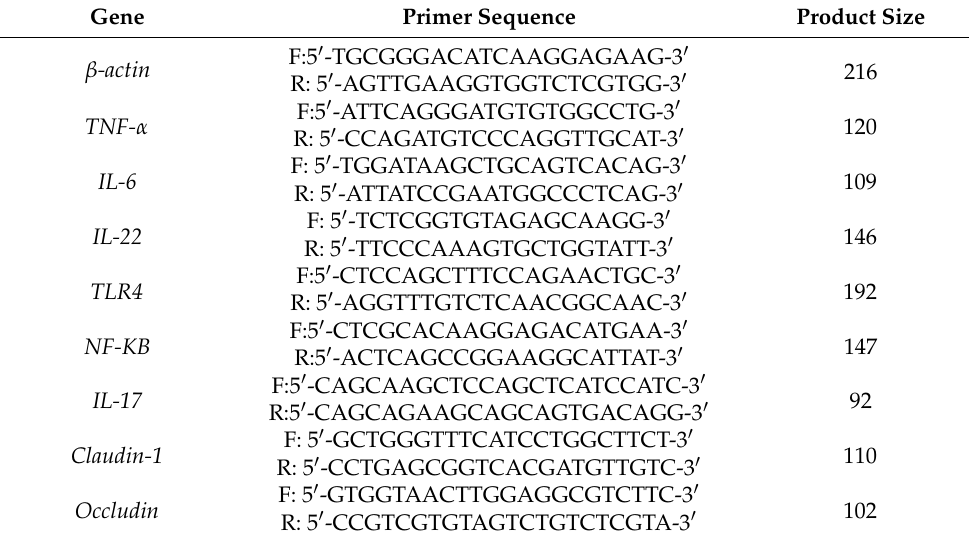
Table 1. Primers for gene expression using real-time